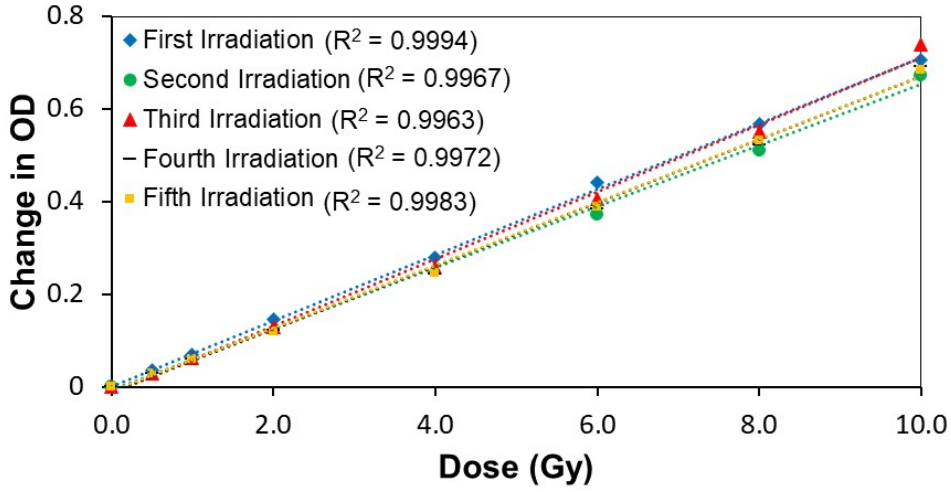
Figure 8. Five separate irradiations of Formulation 3 Group 1 with seven cuvettes ranging from 0.5–10 Gy dose. The reirradiations were performed well after the cuvettes had cleared back to a stable baseline OD following the previous irradiation. Least squares linear fits to each of the five data sets are shown above, with the R 2 coefficient included for each.